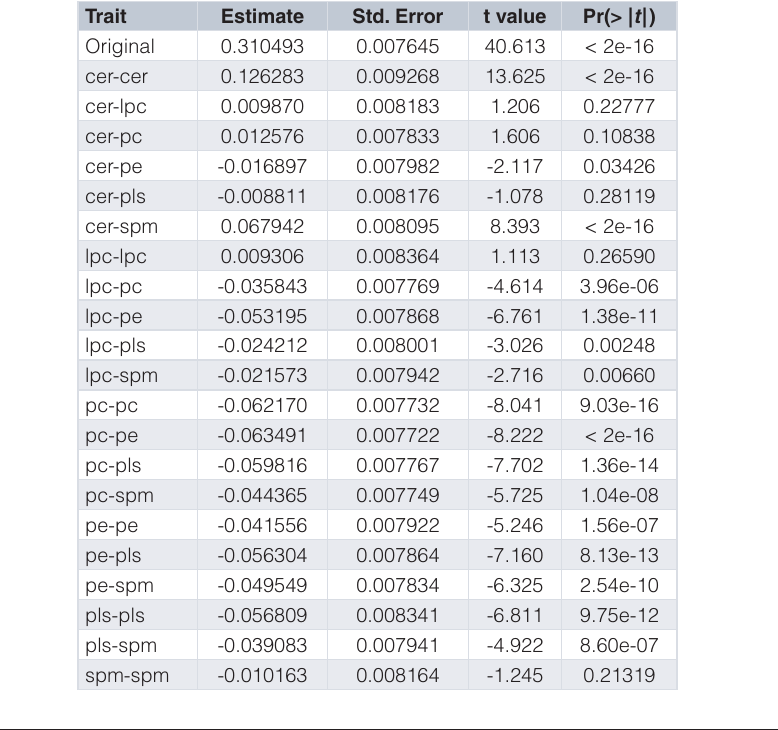
Table S4. Nominal p -values for the analysis of SNPs previously associated with circulating sphingolipid concentrations in Vis data. Lead trait : the original trait for which the association signal was most significant in Vis data. Lead percentage : the molar percentage, for which the most significant association was obtained. Lead Ratio : the ratio, for which the most significant association was obtained. OmicA: OmicABEL, our implementation of CLAK-E ig ; FASTA: the two-step approach 19–21 (as implemented in MixABEL::GWFGLS); LRT: the full likelihood ratio test based LMM 18,22 (as implemented in MixABEL::FMM); Gra- γ : Grammar- γ 25 (as implemented in the GenABEL-package 29